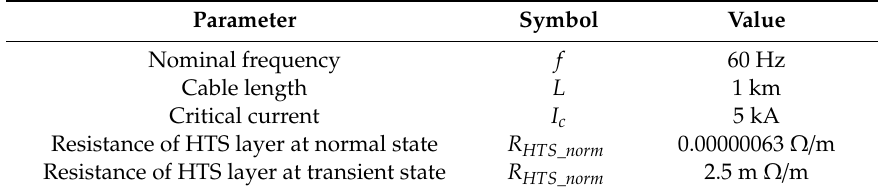
Figure 2. Operation characteristic and equivalent scheme of co-axial HTS cable adopted from [21]: ( a ) current flow into each phase in the normal state; ( b ) current flow into each phase in the transient state; ( c ) equivalent circuit of the HTS power cable. Table 1. System parameters. Table 1. System parameters.